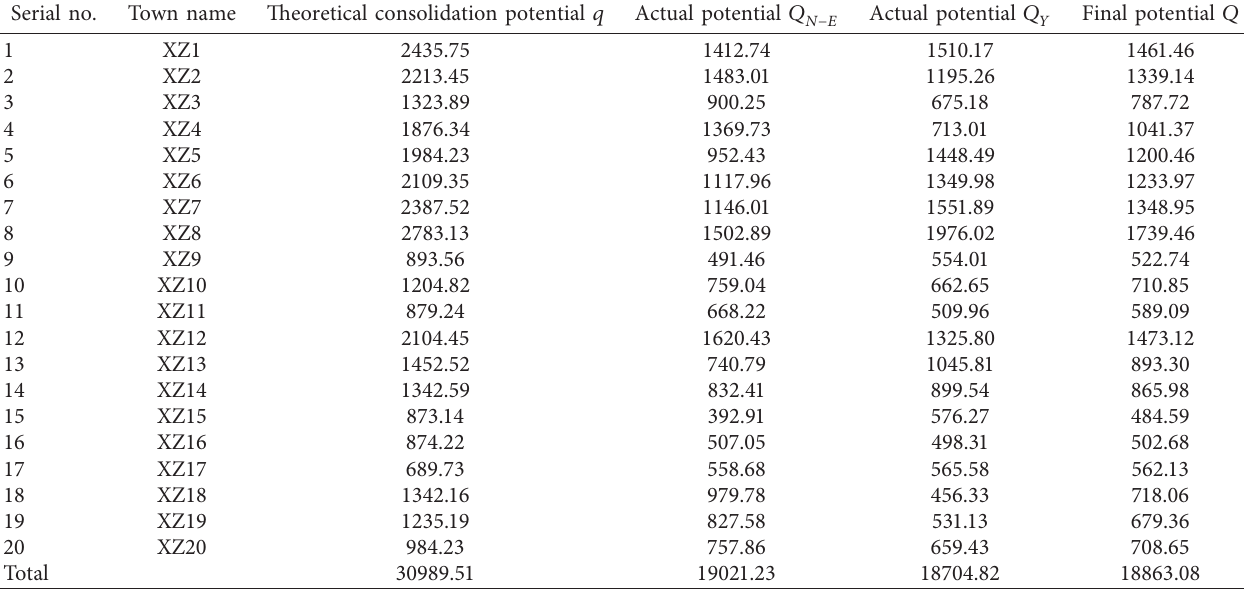
Table 10: Final calculation of rural residential land consolidation realistic potential of 20 towns in Rugao City. Serial